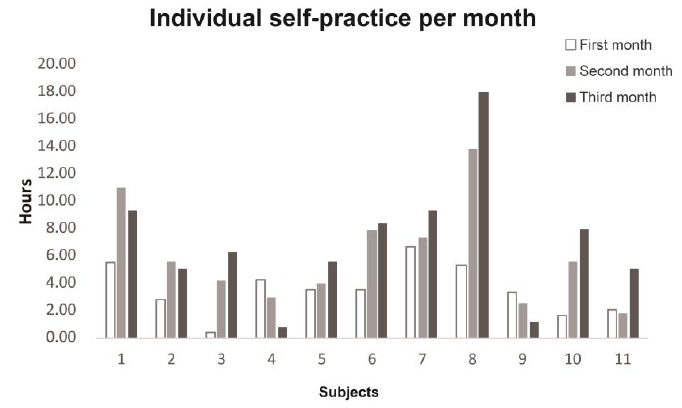
Figure 1. Individual self-practice hours per month of participants.